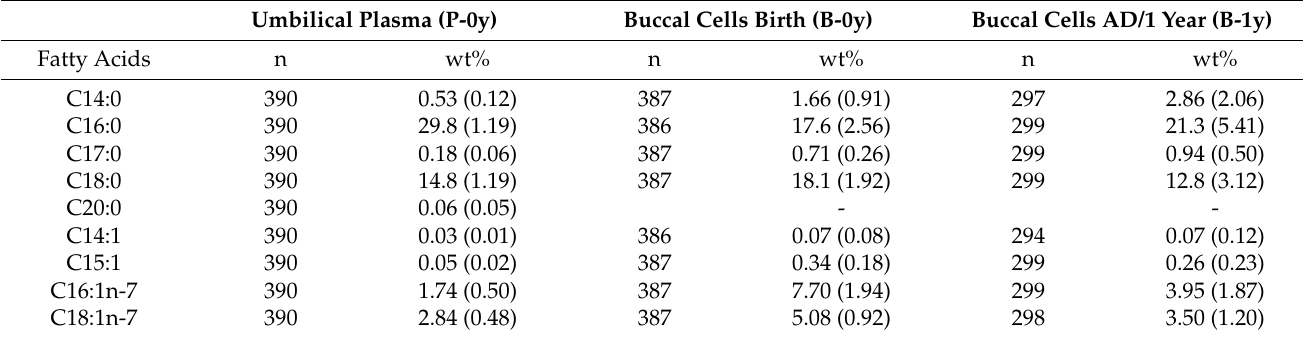
Table 2. GPL-FA content in different